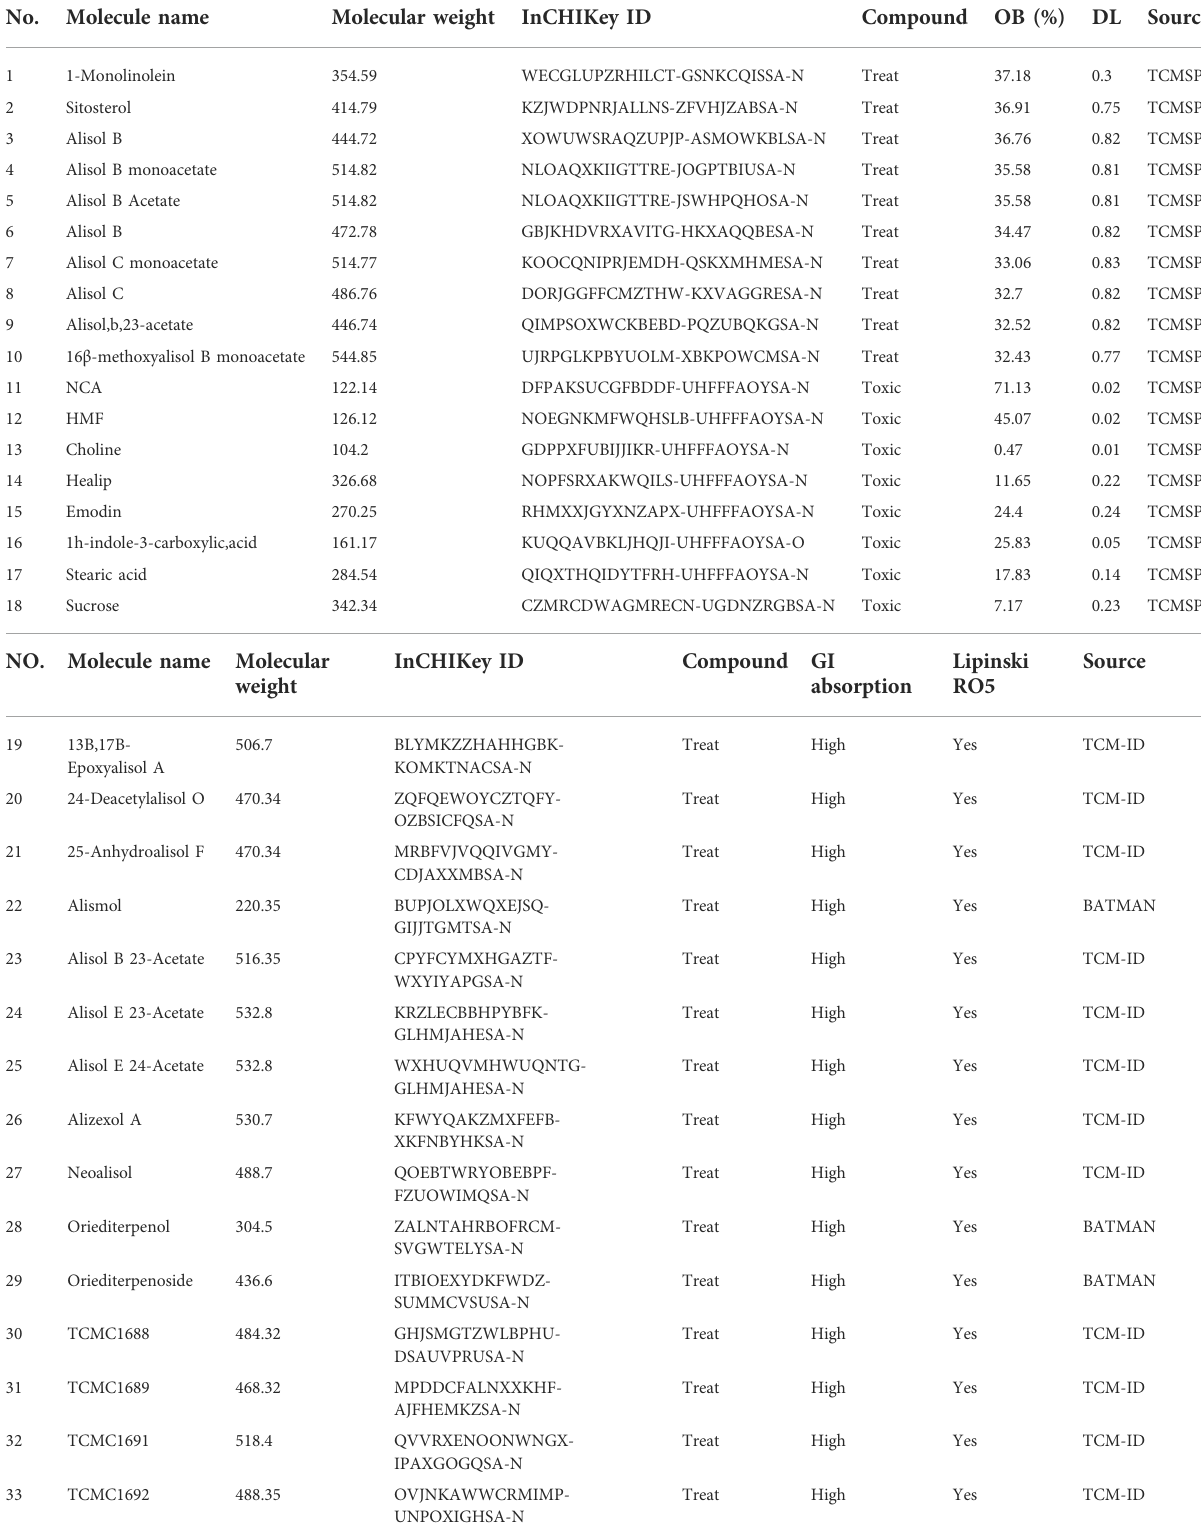
TABLE 1 The chemical characteristics of 39 AO bioactive compounds obtained in TCMSP, TCM-ID, TCM@Taiwan, and BATMAN-TCM database.